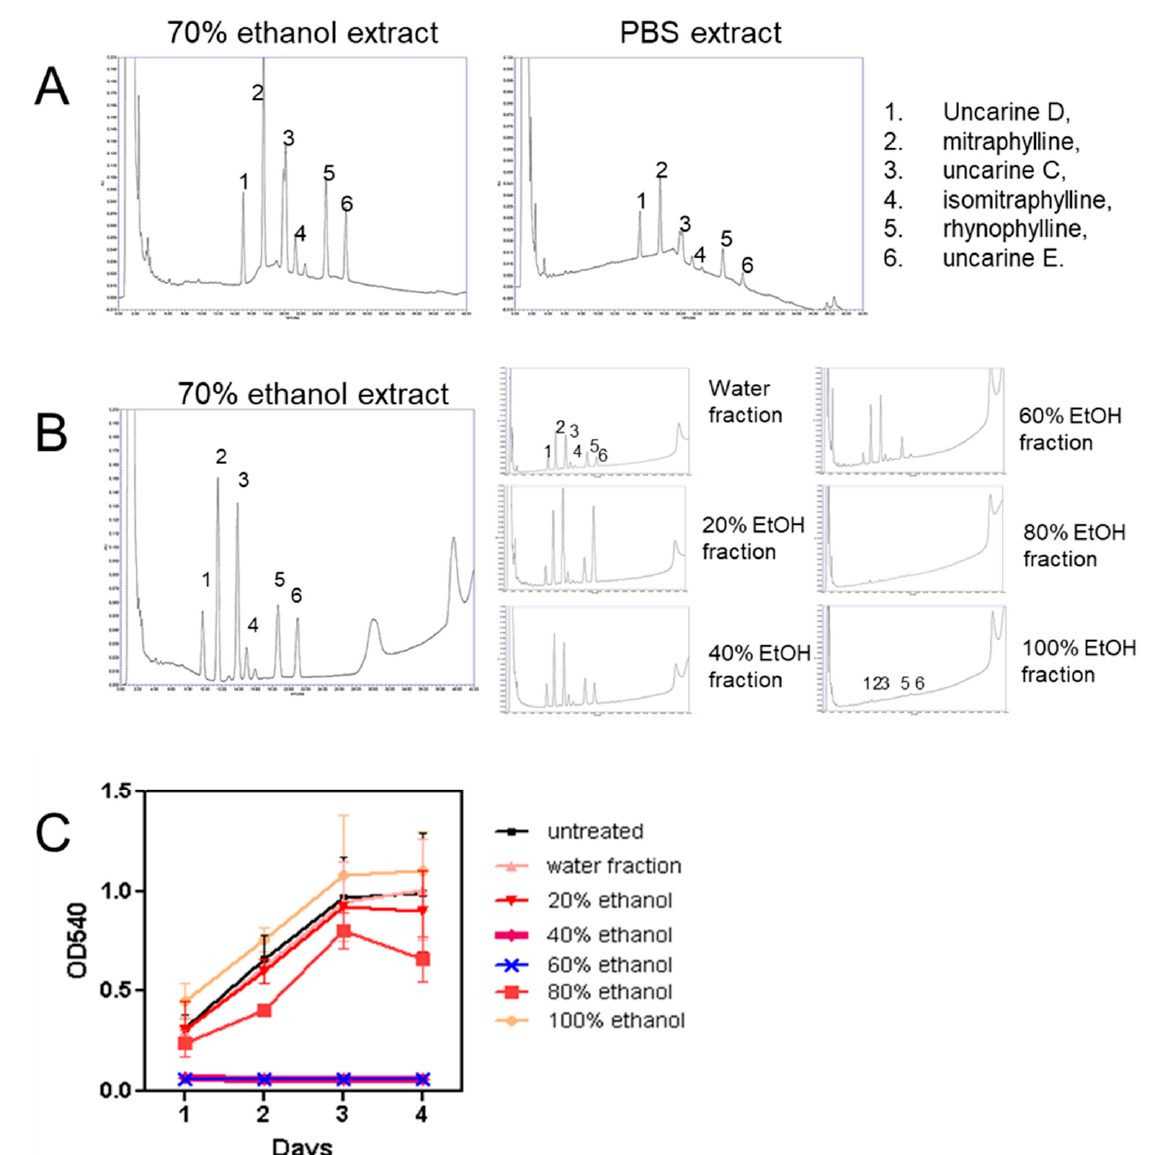
Figure 2. The analysis of Uncaria tomentosa extracts using HPLC. Uncaria tomentosa was extracted by boiling in ( A ) 70% ethanol or PBS, clarified by filtration and then subjected to HPLC using a C18 column; ( B ) an ethanol extract of Uncaria tomentosa was fractionated on a PVPP column and fractions eluted at 100% water, 20% ethanol, 40% ethanol, 60% ethanol, 80% ethanol, and 95% ethanol were concentrated and subjected to HPLC. The peaks, detected by absorbance at 245 nm, were identified by comparison to the elution of standards for Uncaria tomentosa under the same conditions on the same day: (1) uncarine D, (2) mitraphylline, (3) uncarine C, (4) isomitraphyline, (5) rhynophyline, and (6) uncarine E; and ( C ) MTT assays were performed to evaluate the effect of treatment with the PVPP fractions on B16-BL6